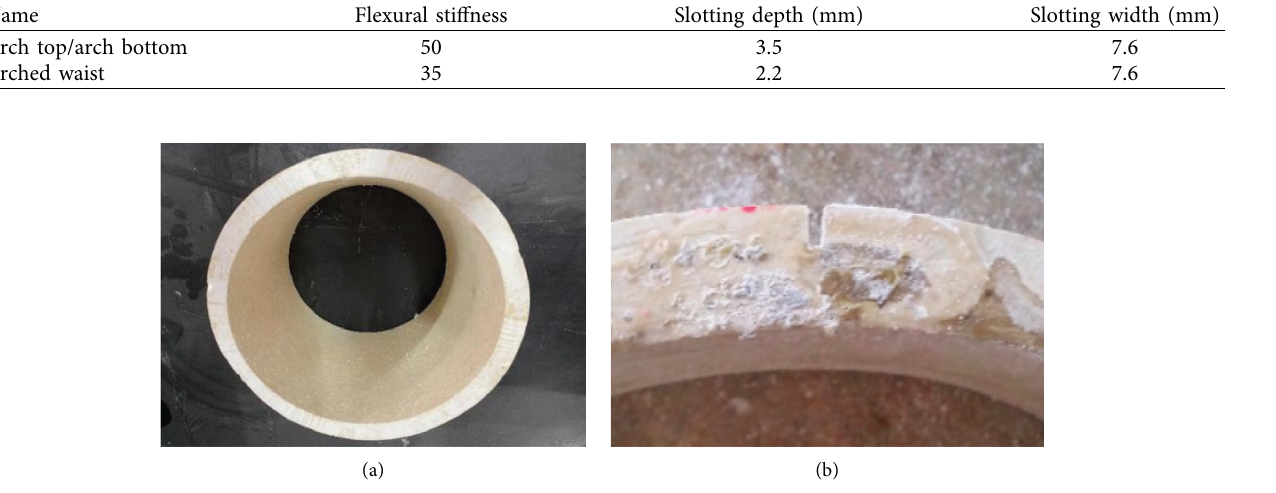
Figure 6: The slotted model of shield tunnel, (a) model pipe casting and forming, and (b) model pipe piece slotting. Table 5: Mass ratio of each constituent of the surrounding rock material.